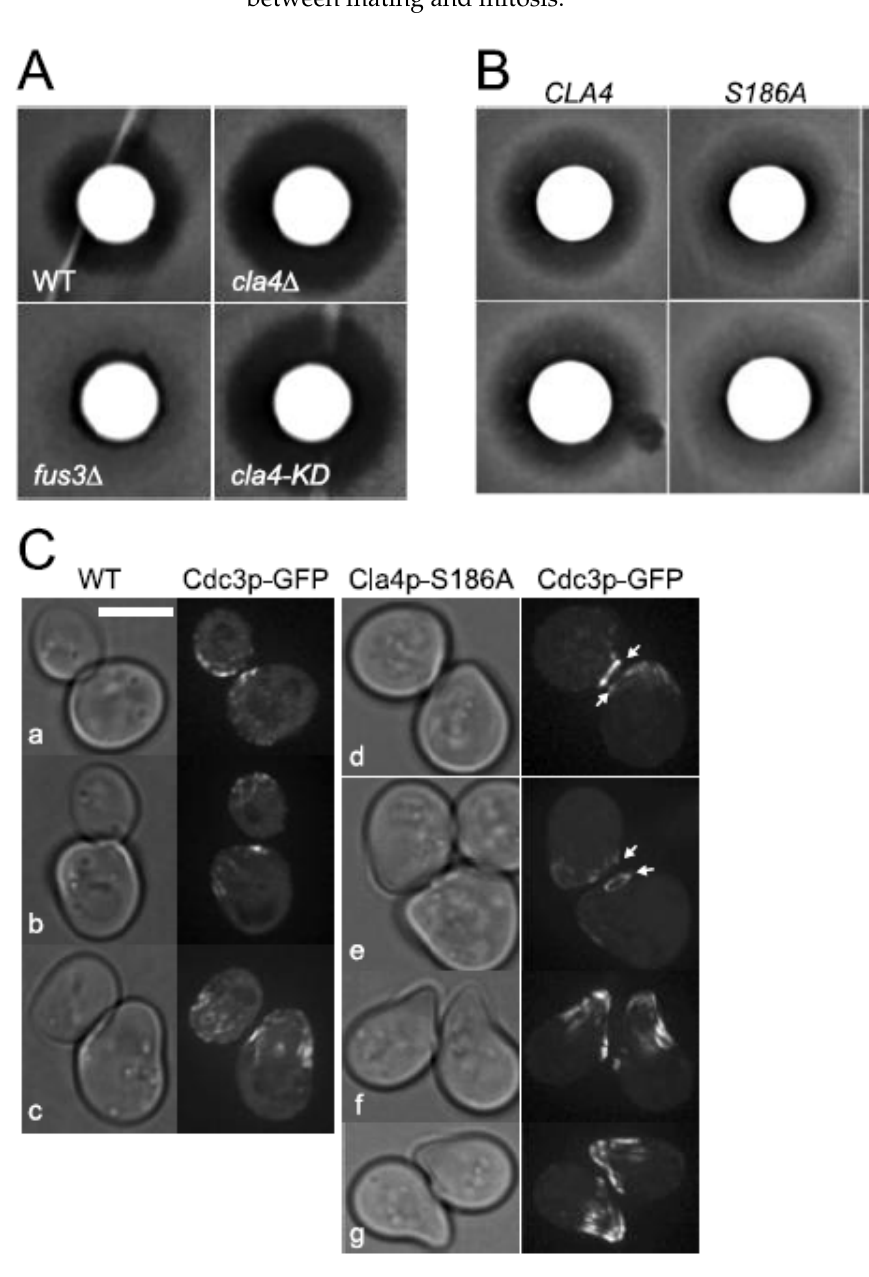
Figure 6. Pheromone sensitivity, recovery, and mating ‐ specific septin structure in cla4 mutants. ( A , B ) Cla4p regulates sensitivity to pheromone; Fus3p phosphorylation of Cla4p delays recovery from pheromone; 10 µ g of α -factor was spotted on filter disks on a thin layer of cells and incubated at 30 ◦ C for 1 ( A , B ) to 2 days ( B ). ( A ) Halo assays of MY15308, MY15311, MY15310, and MY15309. ( B ) Halo assays of MY15342, MY15344 and MY15345. ( C ) Cdc3p-GFP (MR5142) were observed 1 h after α -factor was added in wild-type and CLA4-S186A cells (MY15953 and 15951) were observed 1 h after α -factor was added. Arrows indicate a mitotic septin ring. Bar, 5 µ m.